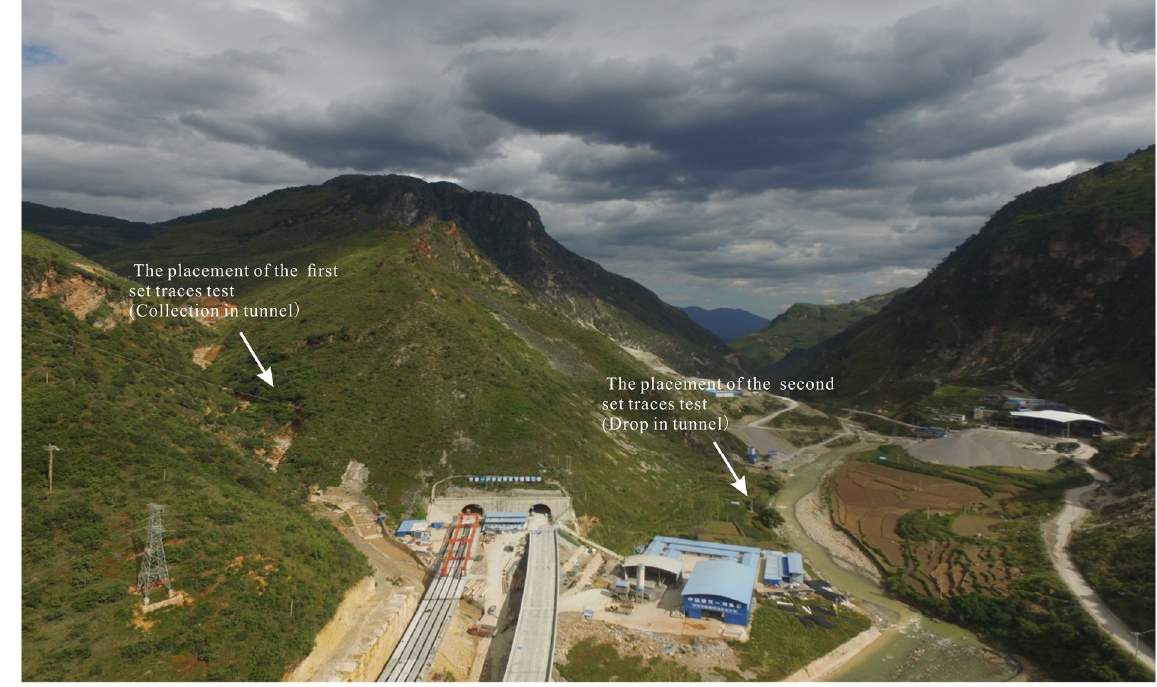
Figure 4. Locations of gullies and springs where tracer tests were performed.